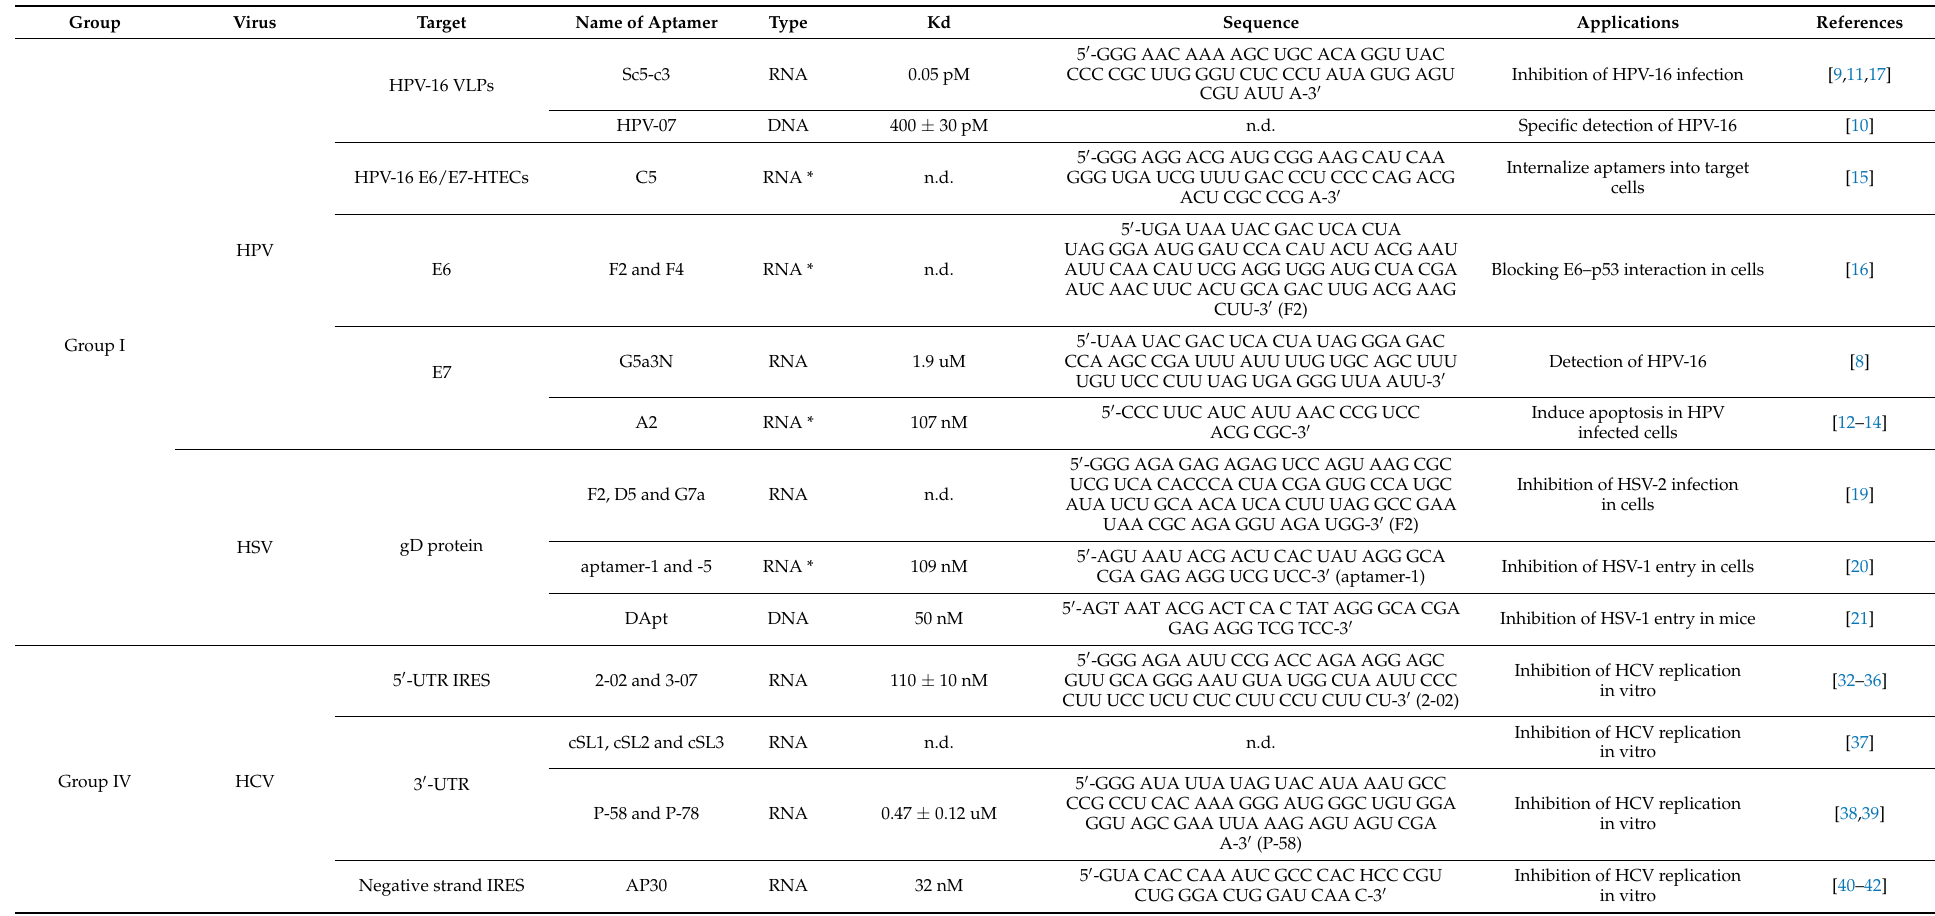
Table 2. Summary data of anti-viral aptamers against virus types classified based on Baltimore classification, in this